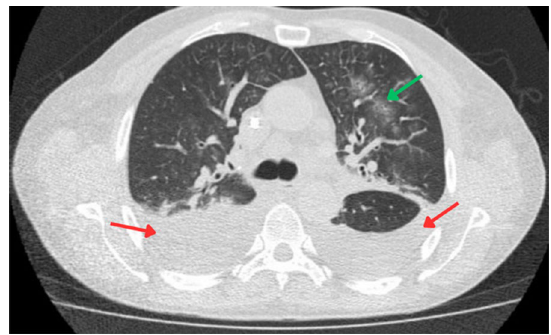
Fig. 4 High‑resolution chest tomography (Axial view). Evidence of bilateral pleural effusion (red arrow) and alveolar bleeding (green